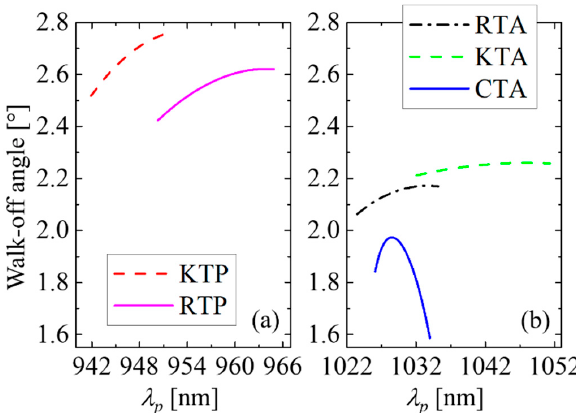
Figure 5. Walk-off angle ( w ) between the interacting beams numerically calculated under Type II EPM: ( a ) KTP and RTP; ( b ) RTA, KTA, and